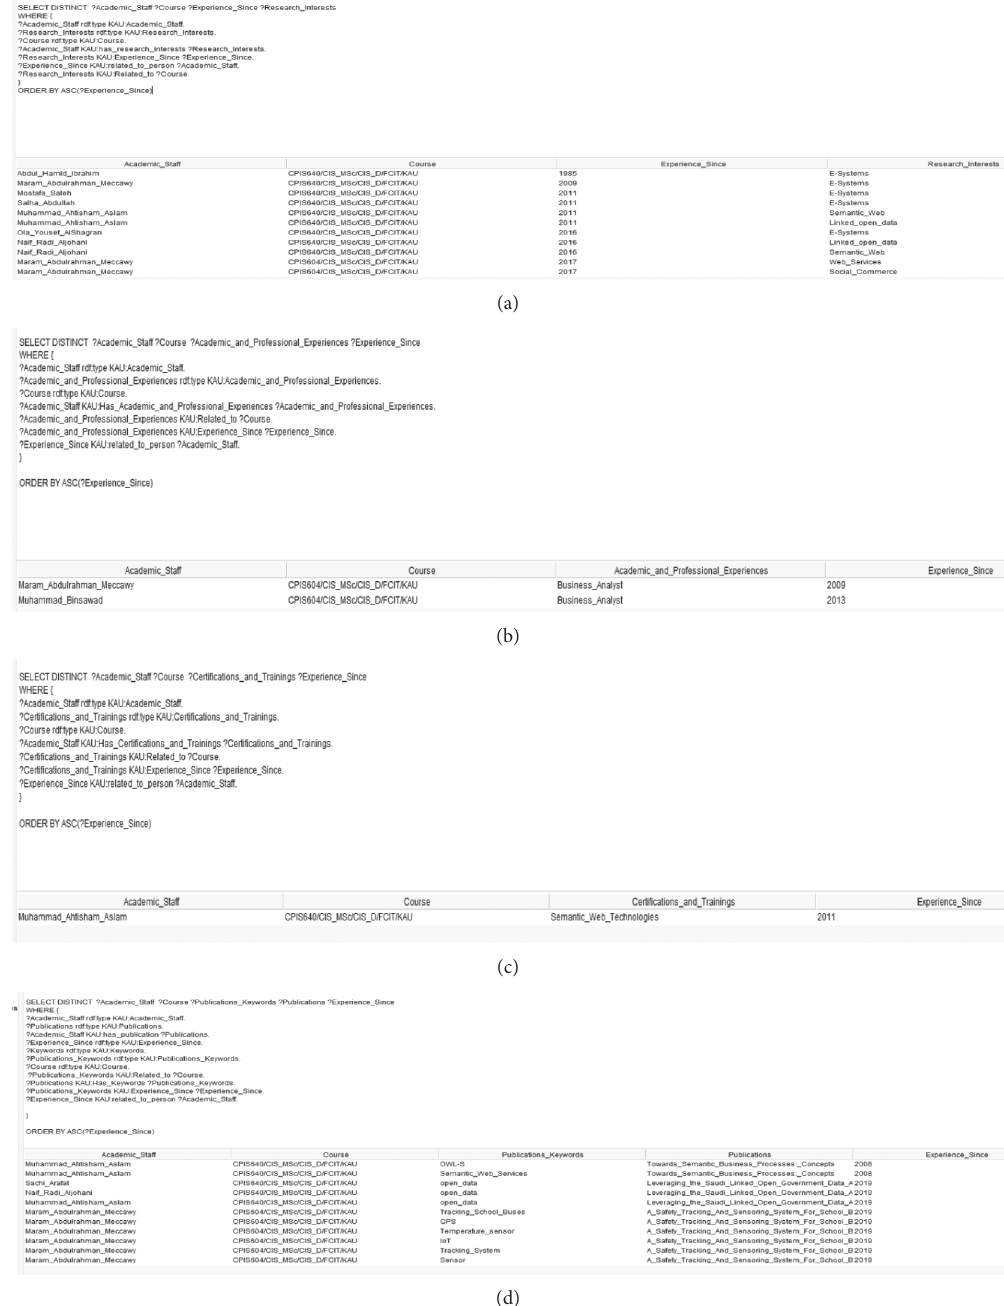
Figure 10: The result of the research interests, certification and trainings, academic and professional experiences, and publications query after criteria. (a) The result of research interests query after criteria. (b) The result of academic and professional experiences query after criteria. (c) The result of certifications and trainings query after criteria. (d) The result of publications query after